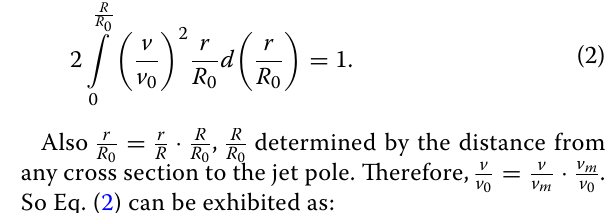
In the above formula, A 0 is the cross-sectional area at the nozzle, R 0 is the nozzle radius and the helium den- sity at the nozzle is ρ 0 . Since the jet density is the same